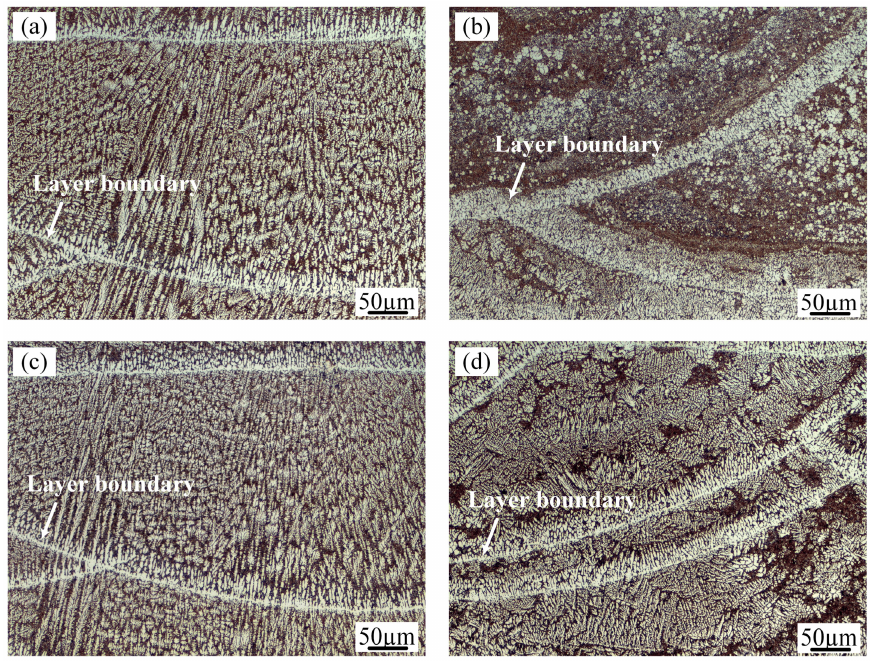
Figure 5. Optical microscopy (OM) micrographs of the Al-12Si samples prepared using ( a ) AS; ( b ) AS under an ultrasonic field; ( c ) RM; ( d ) RM under an ultrasonic